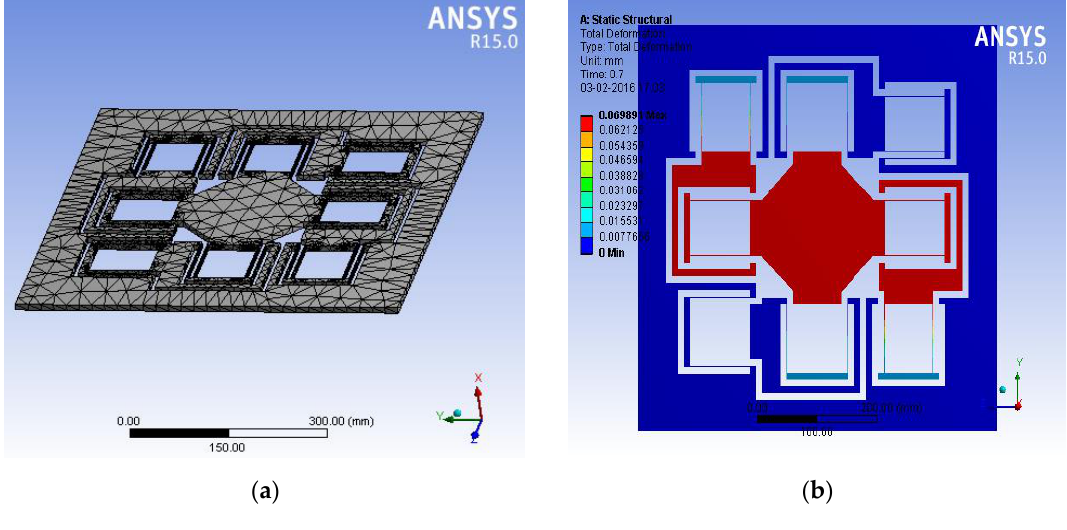
Figure 9. ANSYS simulation of the biflex mechanism.